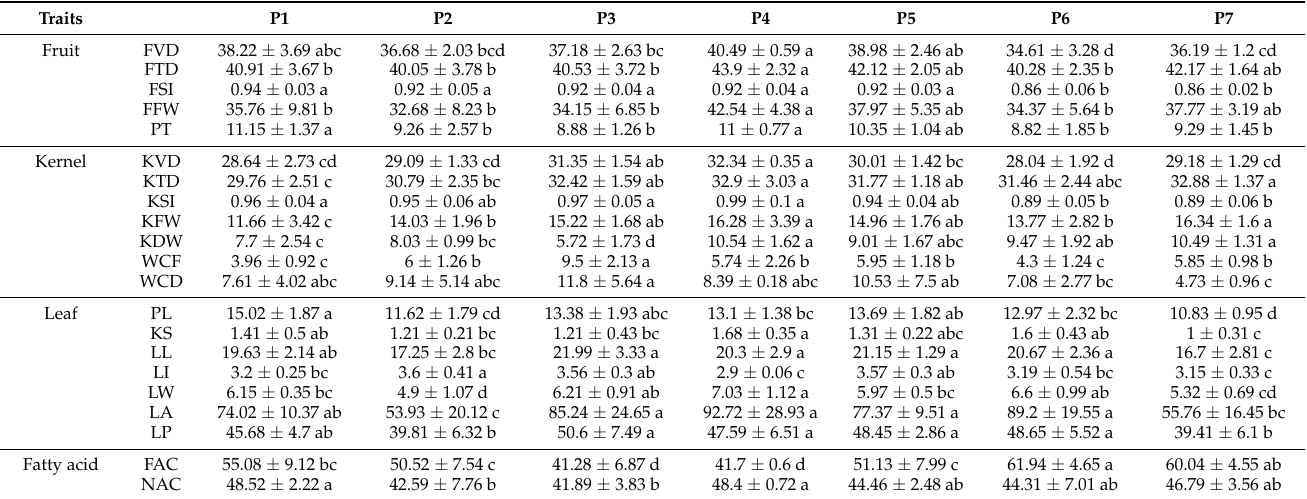
Table 3. Mean value, standard deviation, and multiple comparison of 21 traits (Means with the same letter are not significantly different at the p < 0.05 level.).